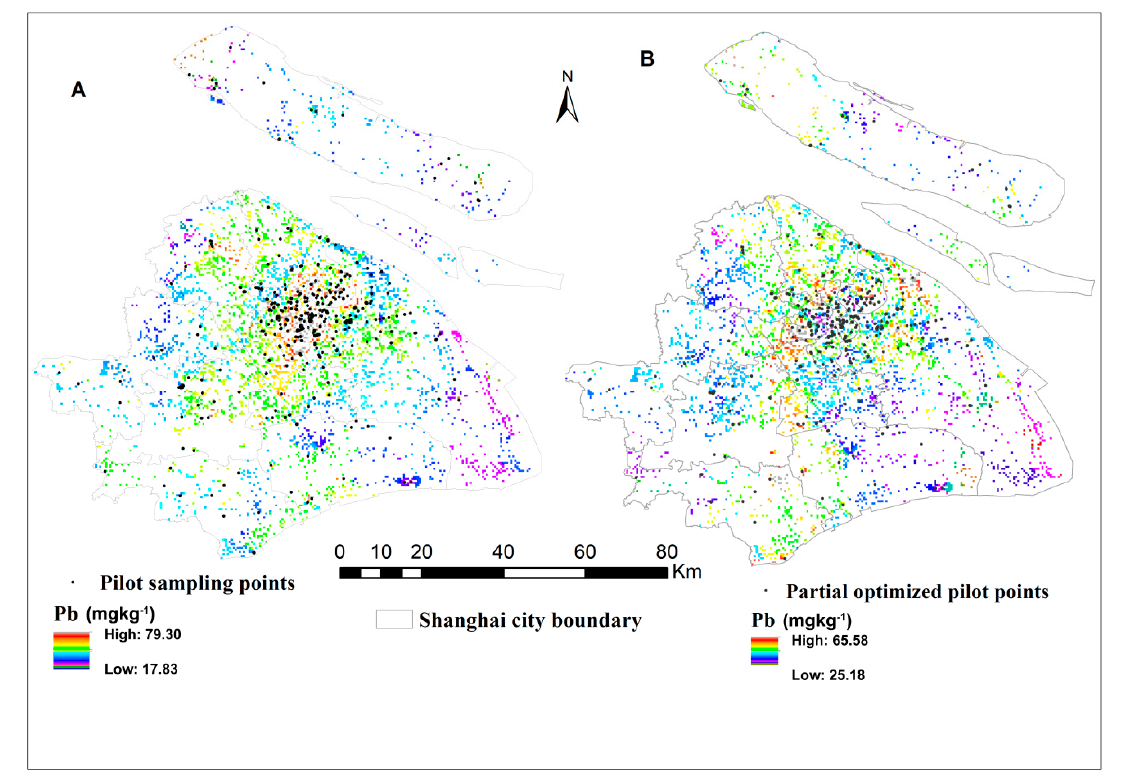
Figure 3. The initial sampling ( A ) and optimized ( B ) design Soil Pb concentration mapping on urban green spaces.